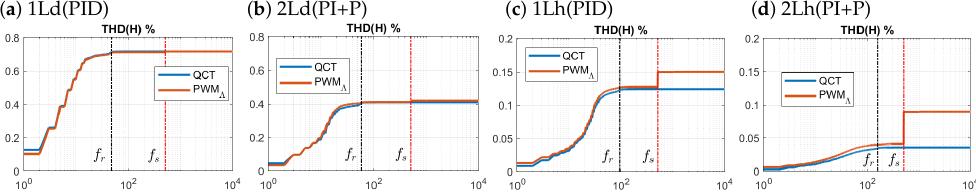
Figure 16. THD H of v out ( t ) as a function of H in optimally tuned control systems with ψ ( t )